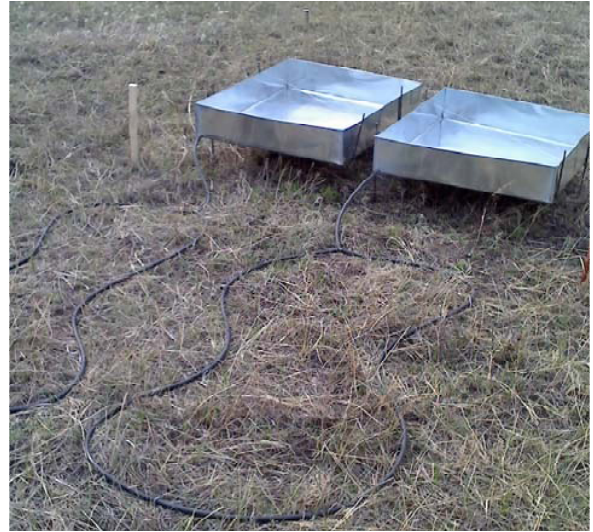
Fig. 1. The picture of increased precipitation treatments in a tem- perate steppe of northeastern